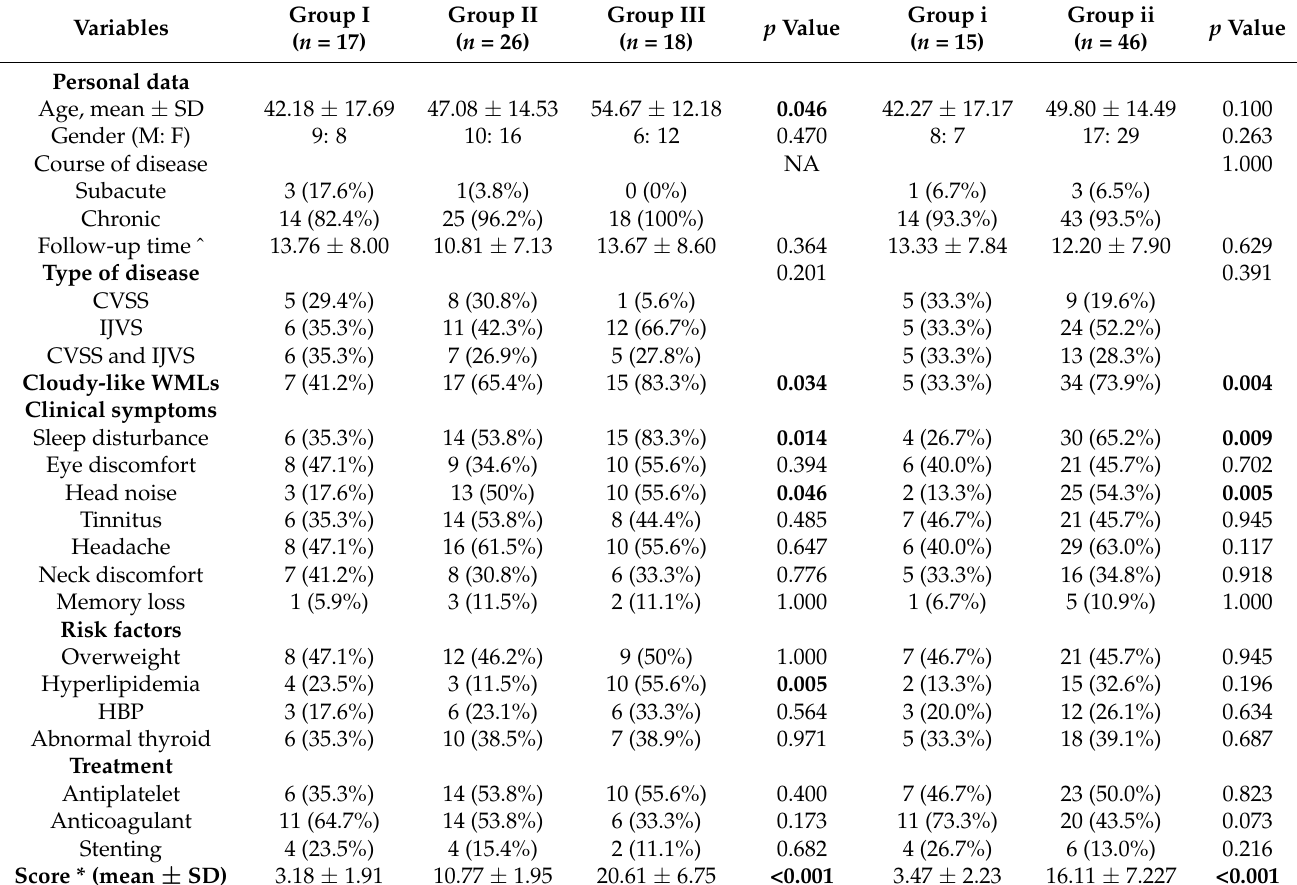
Table 2. Analysis of significance between CVOD-associated anxiety/depression